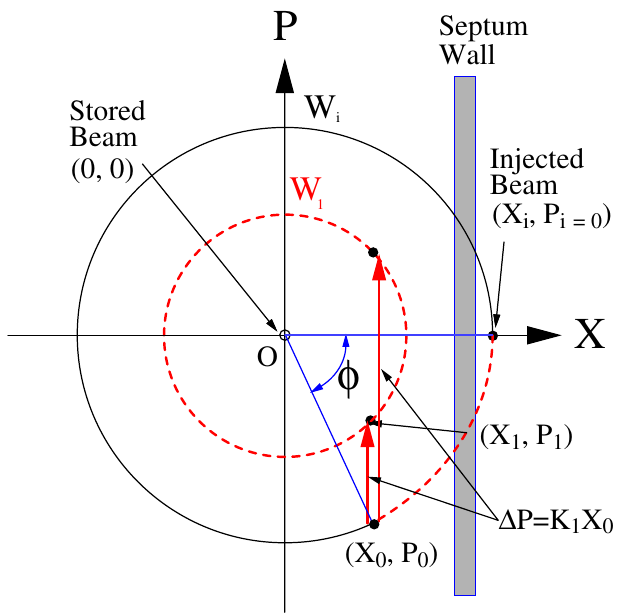
FIG. 6. (Color) Same as Fig. 4, but using a single PQM instead of several kickers for the beam injection. (cid:5) denotes the phase advance between the injection point and the location of the represents the normalized strength of the PQM. PQM, and K 1 The dashed line shows the trajectory of the injected